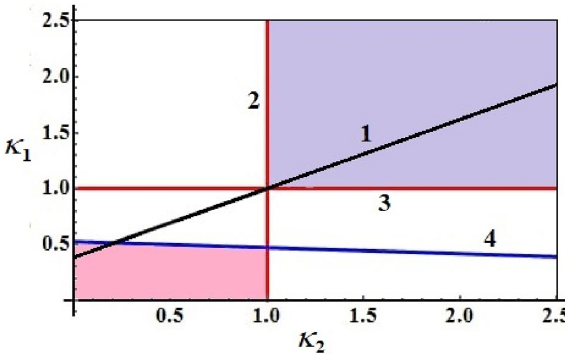
Figure 3. Sketches the areas of quasi-stationary solutions.